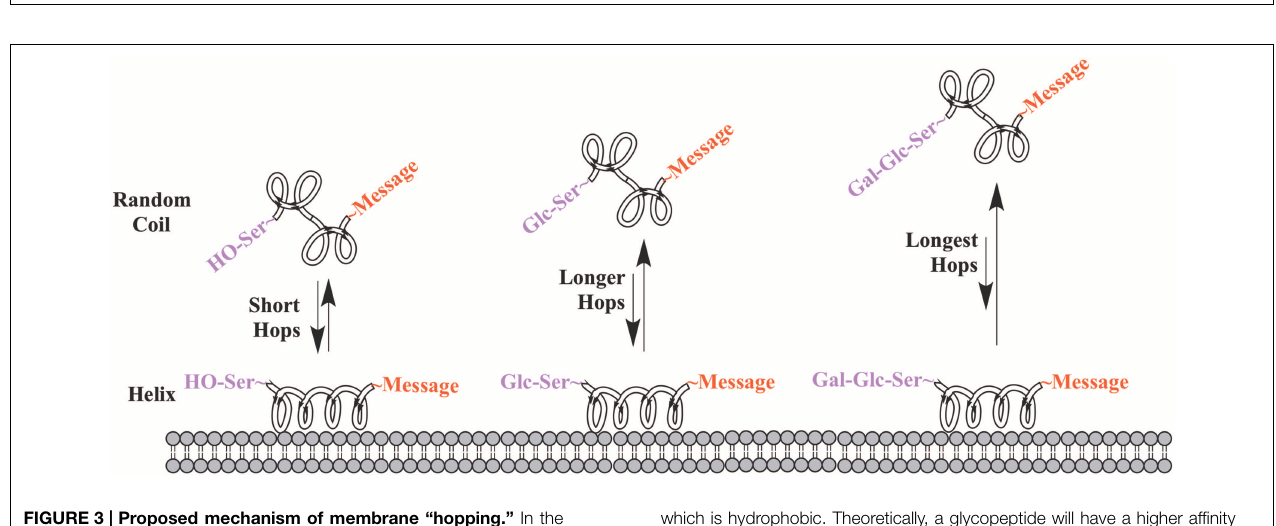
FIGURE 3 | Proposed mechanism of membrane “hopping.” In the CNS, a peptide will be present in equilibrium between two primary conformations: a random coil in aqueous environments, and a helix on a membrane surface. This equilibrium is governed by the peptide’s ampipathicity: the proportion of the peptide that is hydrophilic vs. that